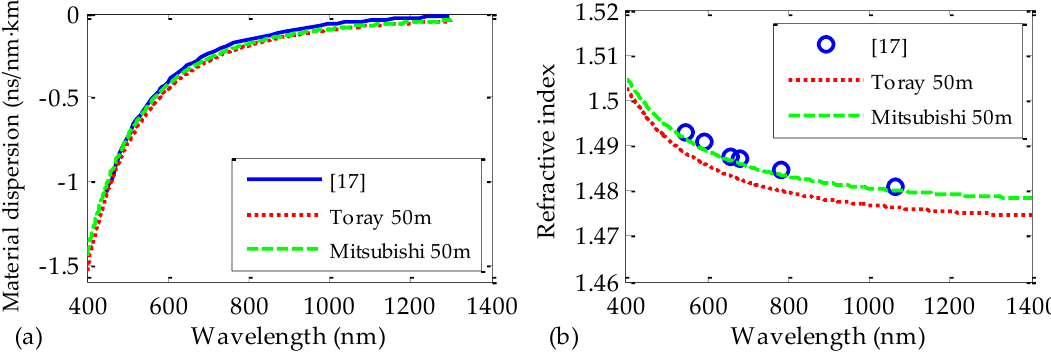
Figure 8. Coefficients of material dispersion ( a ) and refractive indices ( b ) obtained for both brands of fiber, together with the values reported by other authors from measurements of fiber preforms [17].